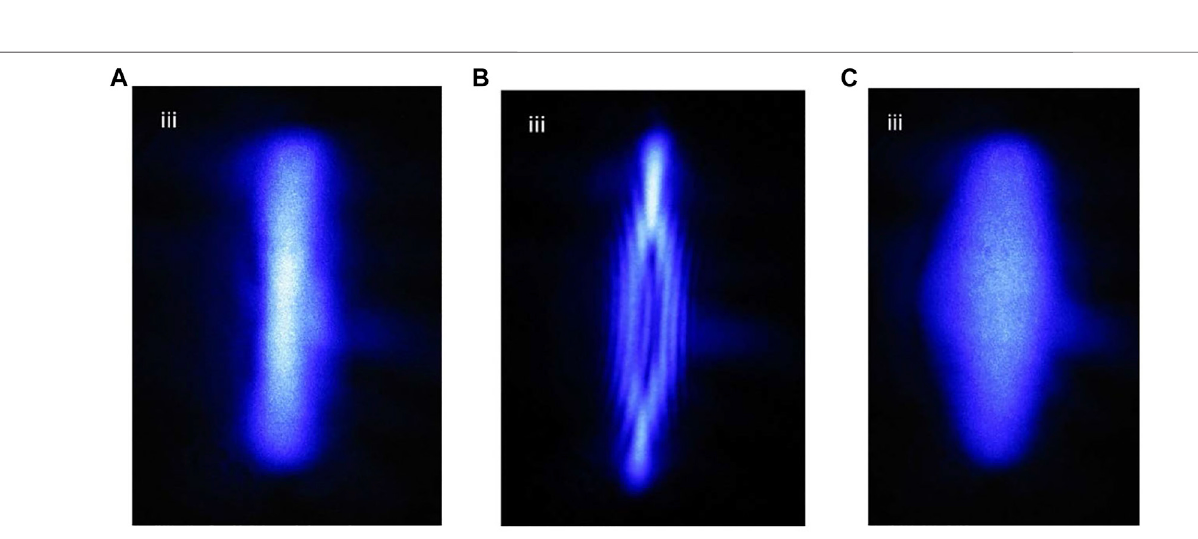
Frontiers in Physics |